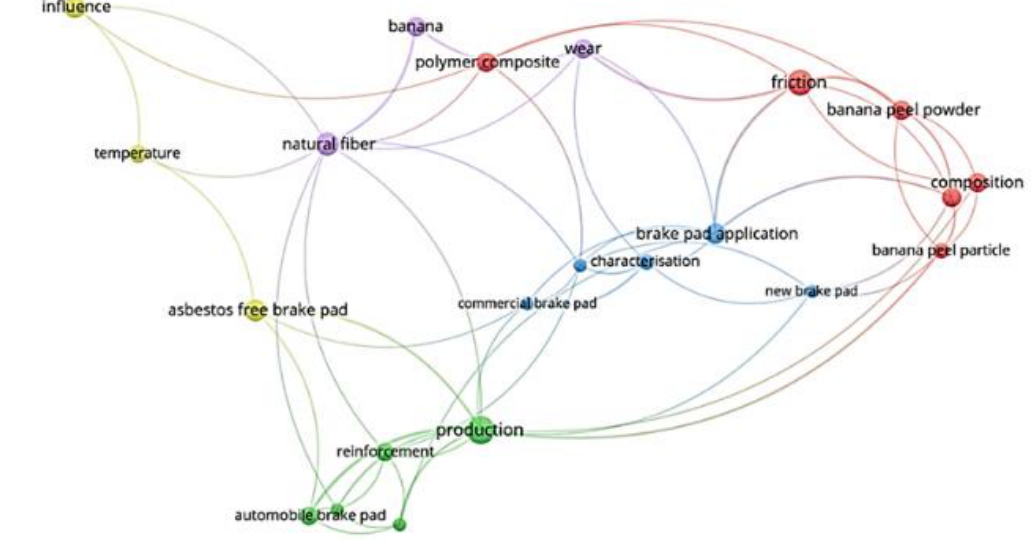
Fig. 1. Network visualization based on